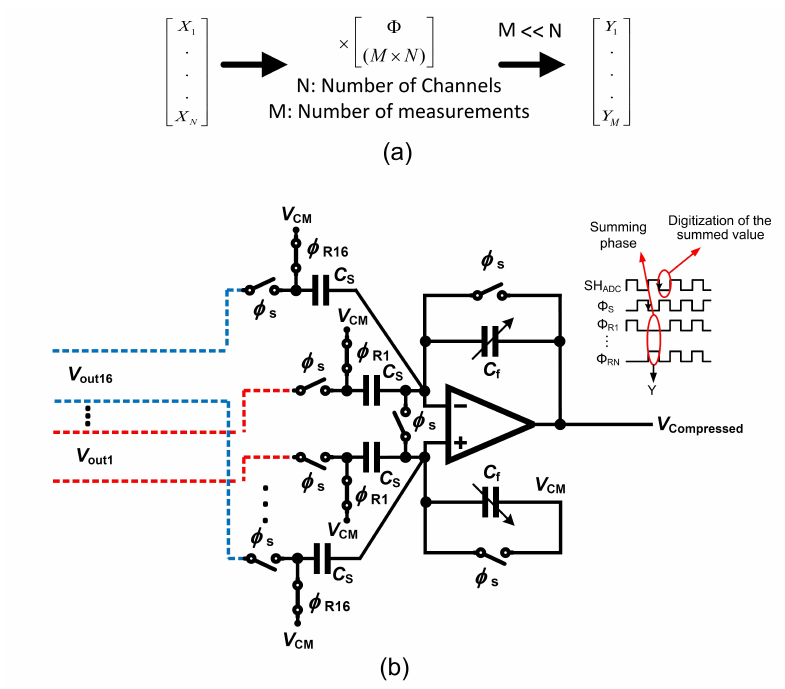
Figure 22. Multichannel compressive sensing (MCS). ( a ) Overview of the MCS concept. ( b ) Structure of the conventional multi-input single-output compressive sensing (MISOCS) block with 16